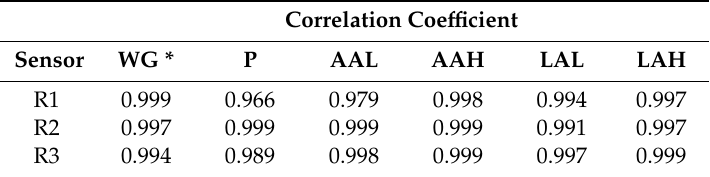
Table 4. Correlation coe ffi cients of the sensors for all sets regarding Q u . * Data from